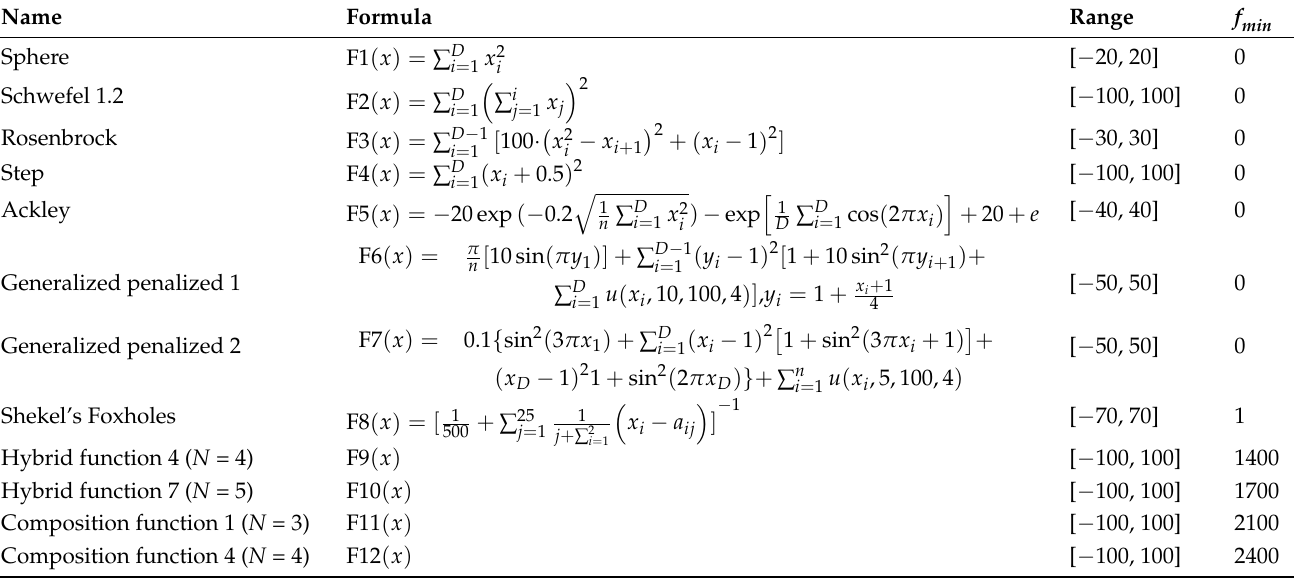
Table 1. Benchmark functions.